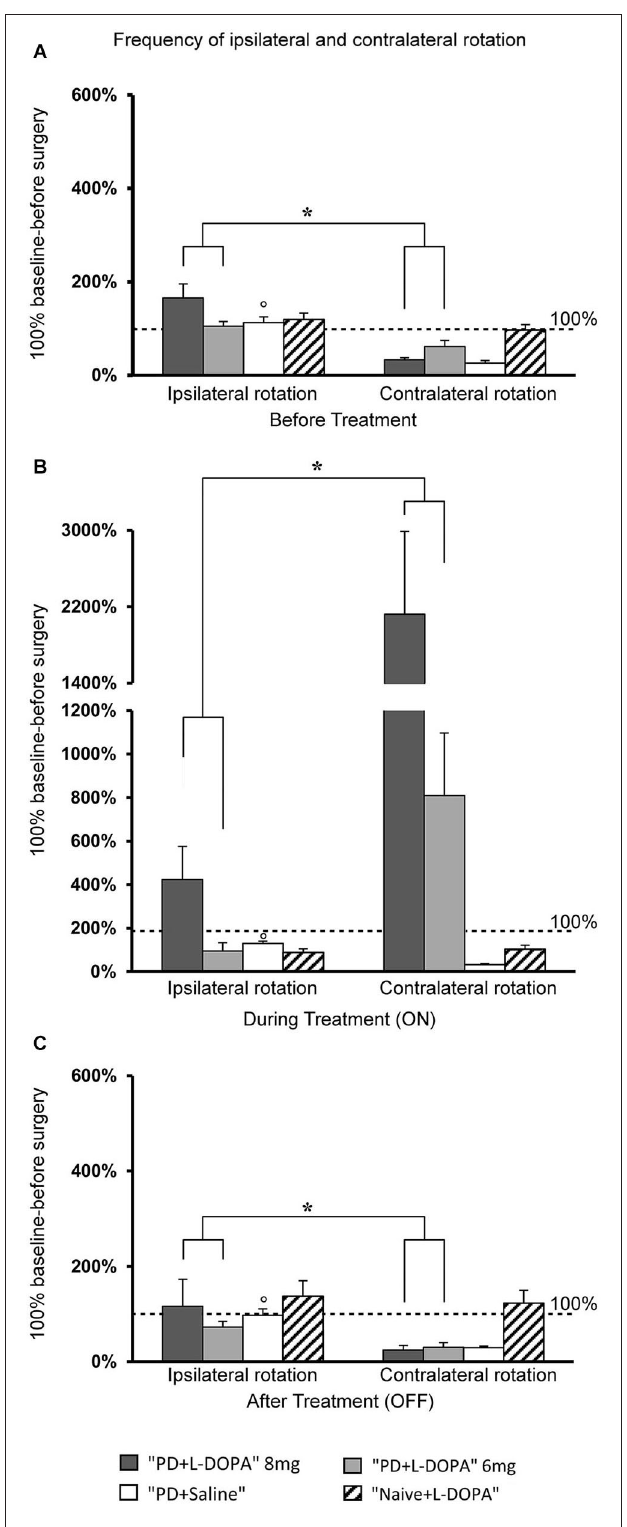
FIGURE 3 | Turning motor activity. (A–C) Mean of values ( ± S.E.M.) of the frequency of rotation in the different treatment phases, expressed as percentages of the individual baseline values (set to 100%) that were